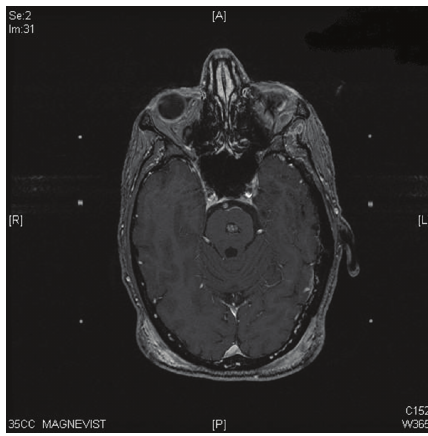
Figure 1: Axial T1 postgadolinium enhanced brain MRI with a visible pontine brain metastasis.